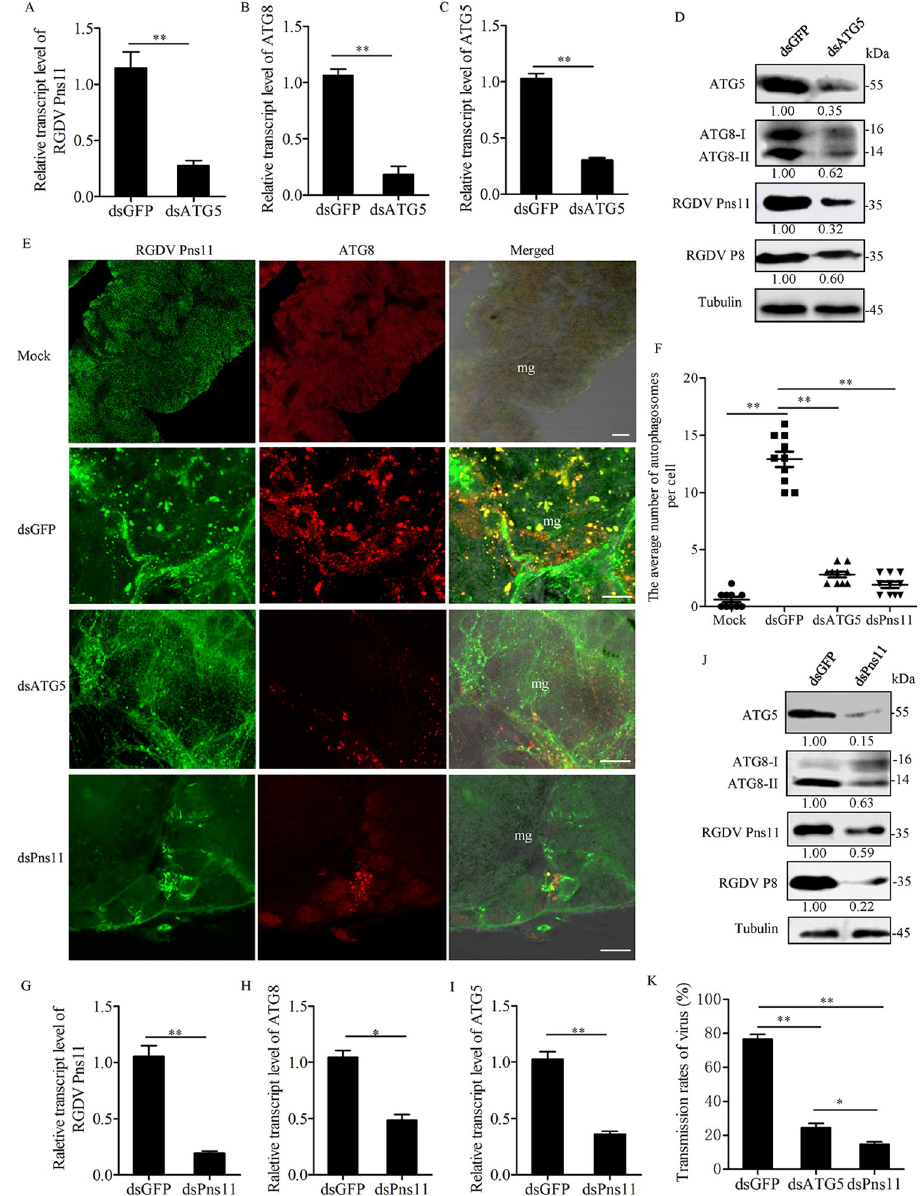
Fig 5. ATG5 is required for Pns11-induced autophagosome formation. ( A-C ) Relative transcript levels of Pns11 ( A ), ATG8 ( B ) and ATG5 ( C ) in viruliferous insects after dsGFP or dsATG5 treatment were measured by RT-qPCR assay. Bars represent means ± SD from three independent experiments. Significance ( �� ) was determined at P < 0.01. ( D ) Accumulation levels of ATG8, ATG5, P8 and Pns11 in viruliferous insects after dsGFP or dsATG5 treatment were tested by western blot assay using ATG5-, ATG8-, P8- and Pns11-specific IgGs. Tubulin was detected as an internal control. Relative protein levels were determined using ImageJ and the accumulation levels of ATG8-II, ATG5, Pns11 and P8 in dsGFP-treated insects were normalized to 1. ( E ) The intestines of viruliferous insects after treatment of dsATG5, dsPns11 or dsGFP were immunolabeled with Pns11-FITC (green) and ATG8-rhodamine (red) at 6 days padp. Mg, midgut. Bars, 5 μ m. ( F ) The average number of ATG8-puncta per cell of viruliferous insects after dsGFP, dsATG5 or dsPns11 treatment. Bars represent means ± SD from more than 10 individual cells. Significance ( �� ) was determined at P < 0.01. ( G-I ) Relative transcript levels of Pns11 ( G ), ATG8 ( H ) and ATG5 ( I ) in viruliferous insects after dsGFP or dsPns11 treatment were measured by RT-qPCR assay. Bars represent means ± SD from three independent experiments. Significance ( �� ) was determined at P < 0.01. ( J ) Accumulation levels of ATG8, ATG5, P8 and Pns11 in viruliferous insects after dsGFP or dsPns11 treatment, as determined by western blot assay using ATG5-, ATG8-, P8- and Pns11-specific IgGs. Tubulin was detected as an internal control. Relative protein levels were determined using ImageJ and the accumulation levels of ATG8-II, ATG5, Pns11 and P8 in dsGFP-treated insects